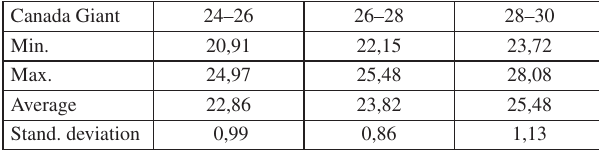
Fig. 16: The distribution of the sample with 24–26 mm size category Fig. 17: The distribution of the sample with 26–28 mm size Table 2: The average values for the heights (mm)